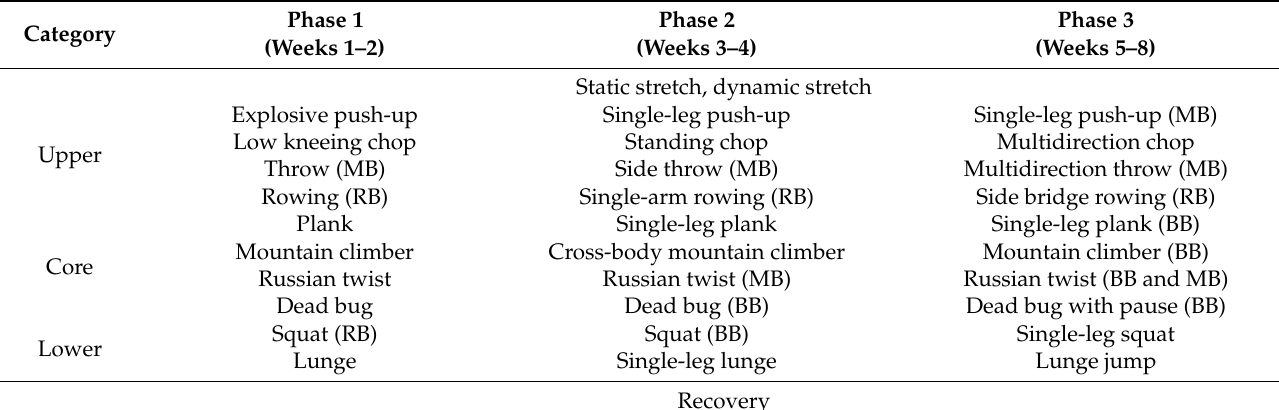
Table 1. Functional-training